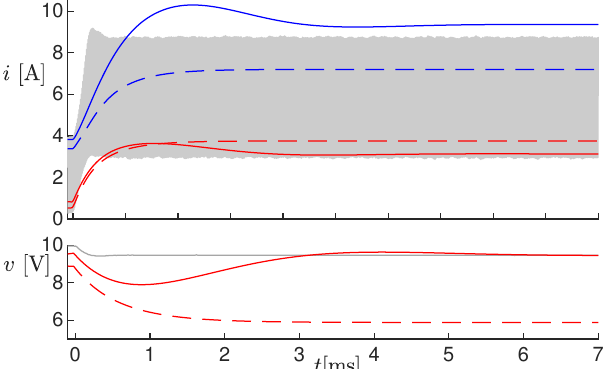
Figure 7. Results of Test #2 with parameter R L increased ten times. The dashed lines are the estimated values obtained with η = 0.